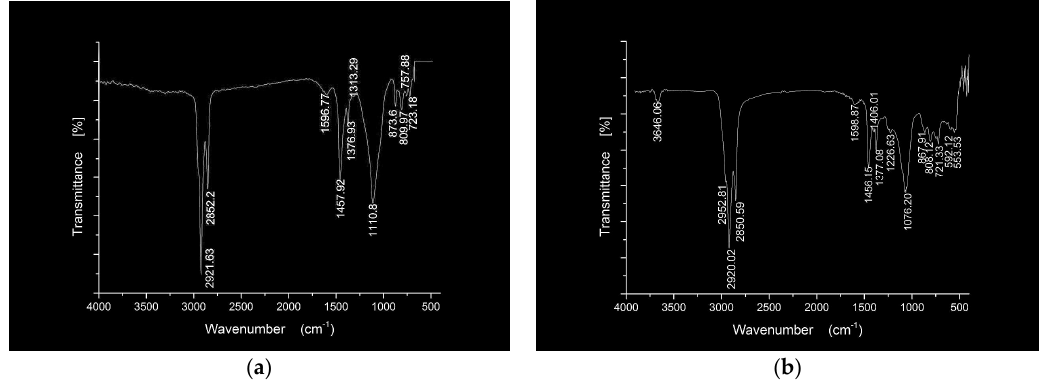
Figure 8. FTIR spectra of the SBA-SP and SCASBA-SP samples. ( a ) SBA-SP; ( b ) SCASBA-SP.